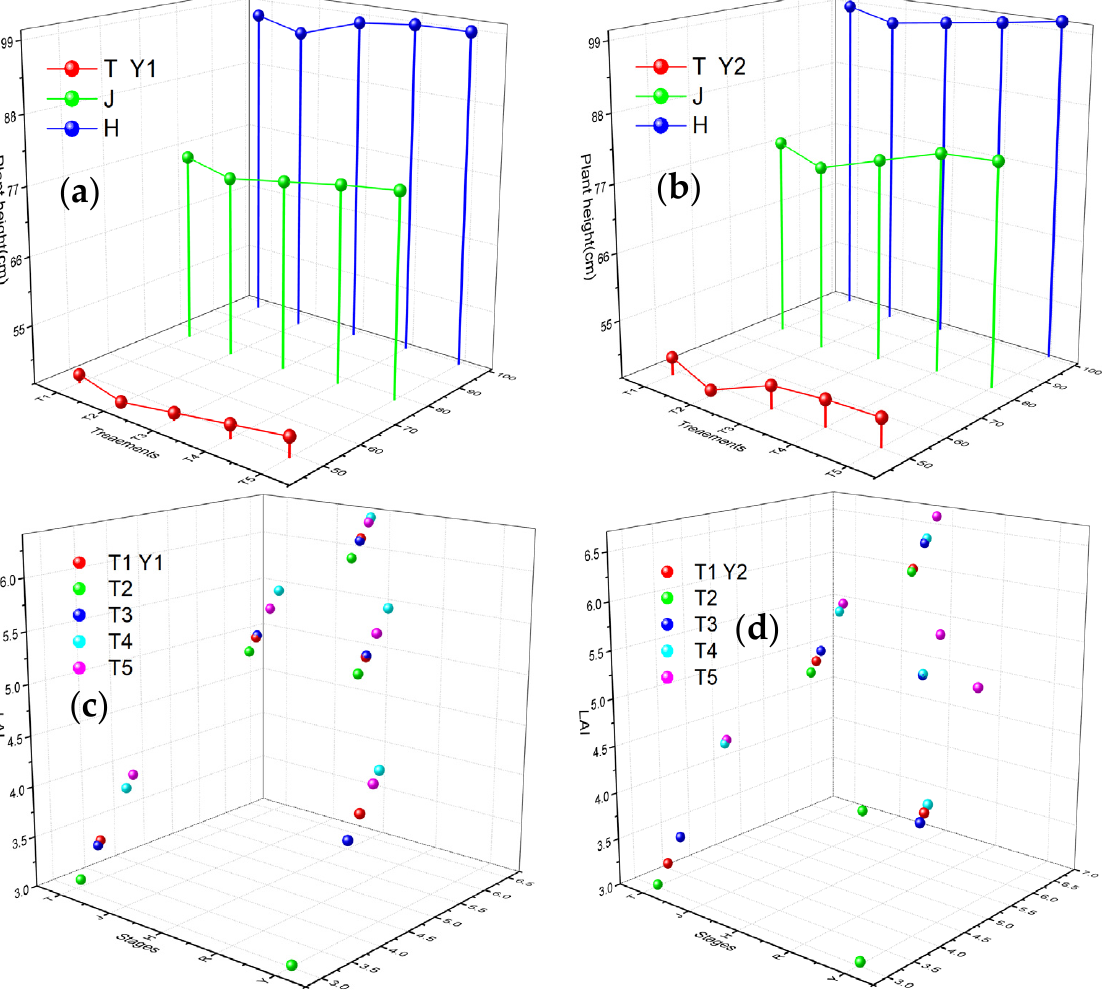
Figure 3. The plant height ( a , b ) and LAI ( c , d ) under the different HA treatments. 3.3. The IPAR and RUE Increased HA improved the RUE (Table 2), and the RUE of the rice distinctly increased after the application of HA. During rice development, the RUE increased rapidly after fertilization and then decreased significantly. Similar to F d , it peaked during the heading stage. At all stages, the RUE in the T4 and T5 treatments was higher than that in the T1 and T3 treatments, with significant differences in the T2 treatment. The RUE in the T4 and T5 treatments was, on average, 8.2% higher than that in the T2 treatment in Y1 and 9.6% higher in Y2. Increased HA also promoted the RUE , IPAR , and F d at all stages, but no significant differences were observed in the T4 and T5 treatments. However, both of them were significantly higher than those in the T1, T2, and T3 treatments. The IPAR in the T4 and T5 treatments was on average 19.2% higher in Y1 and 24% higher in Y2, relative to the T1, T2, and T3 treatments. The F d in the T4 and T5 treatments was on average 19.5% higher in Y1 and 23.6% higher in Y2, relative to the T1, T2, and T3